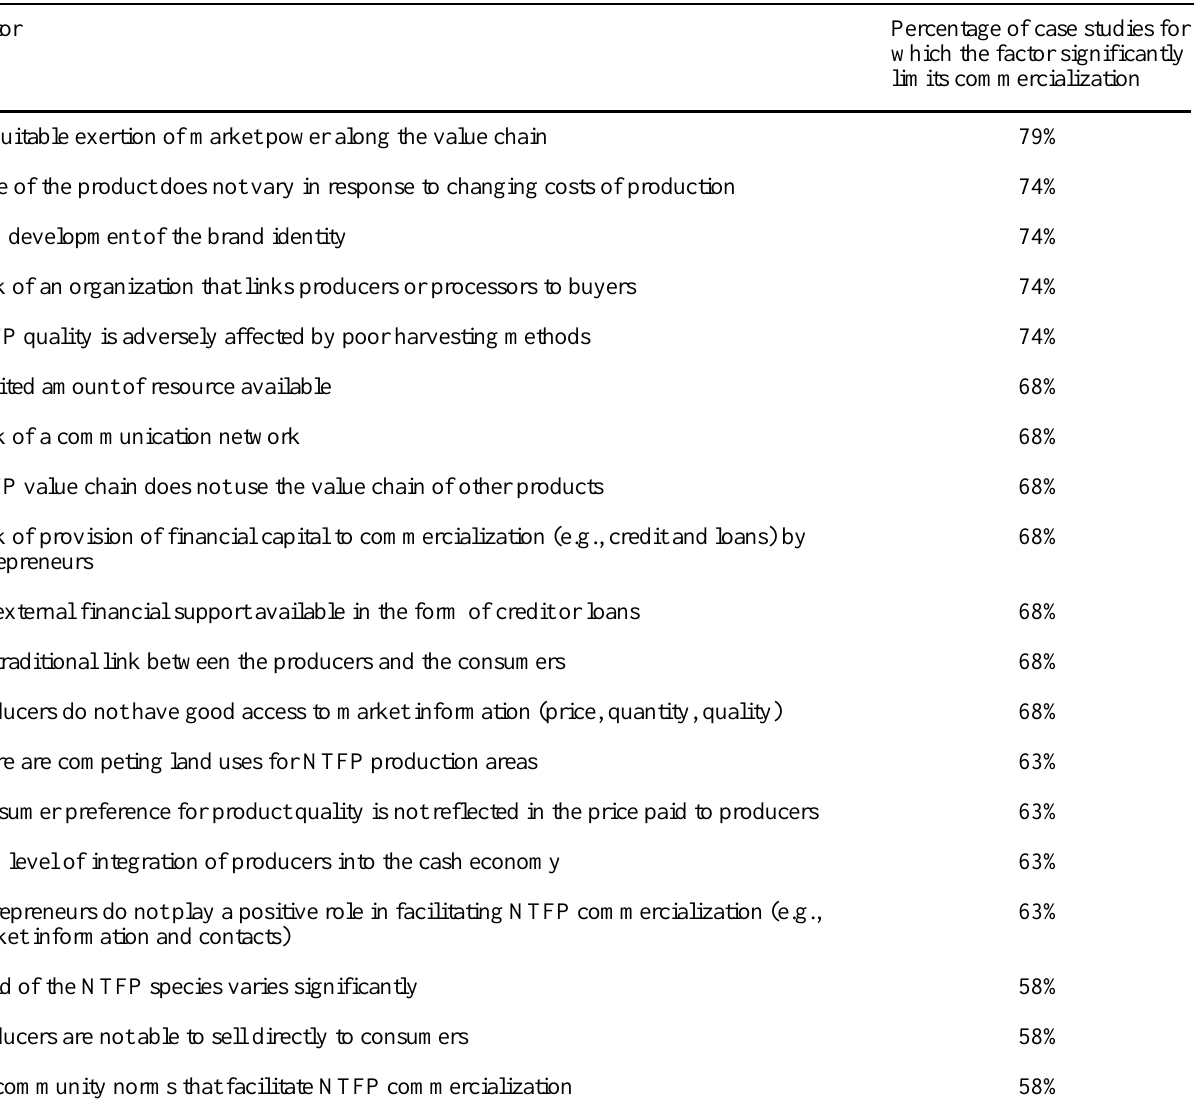
Table 2. List of the factors that limited commercialization of more than half of the case studies considered by the CEPFOR